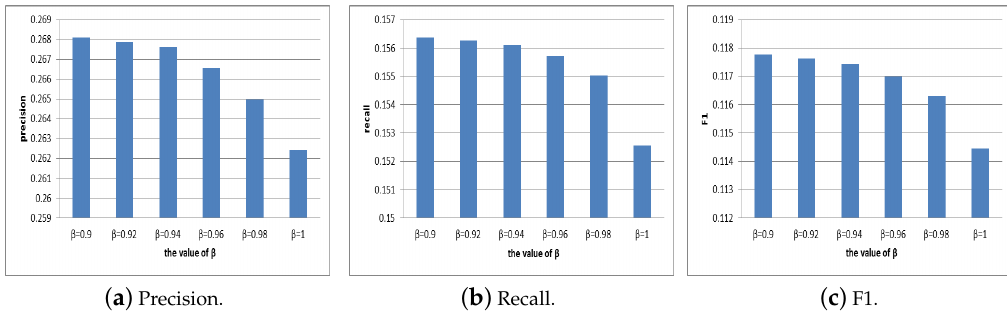
Figure 7. Selection of Parameter β . ( a ) Description of precision in the first panel. ( b ) Description of recall in the second panel. ( c ) Description of F1 in the third